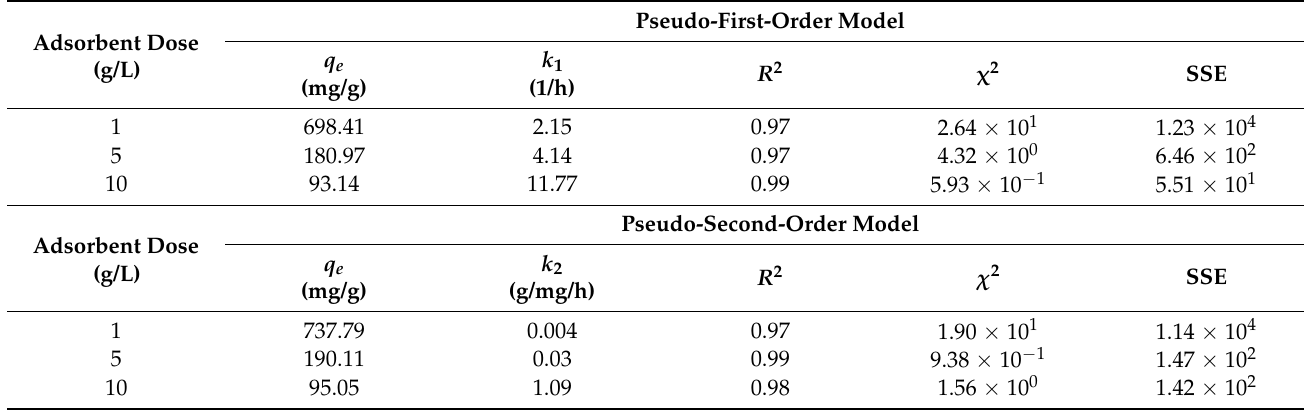
Table 4. Kinetic model parameters obtained from model fitting to experimental data.